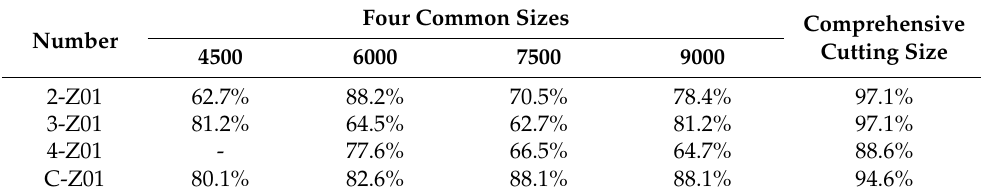
Table 16. Material utilization rate under four common sizes.